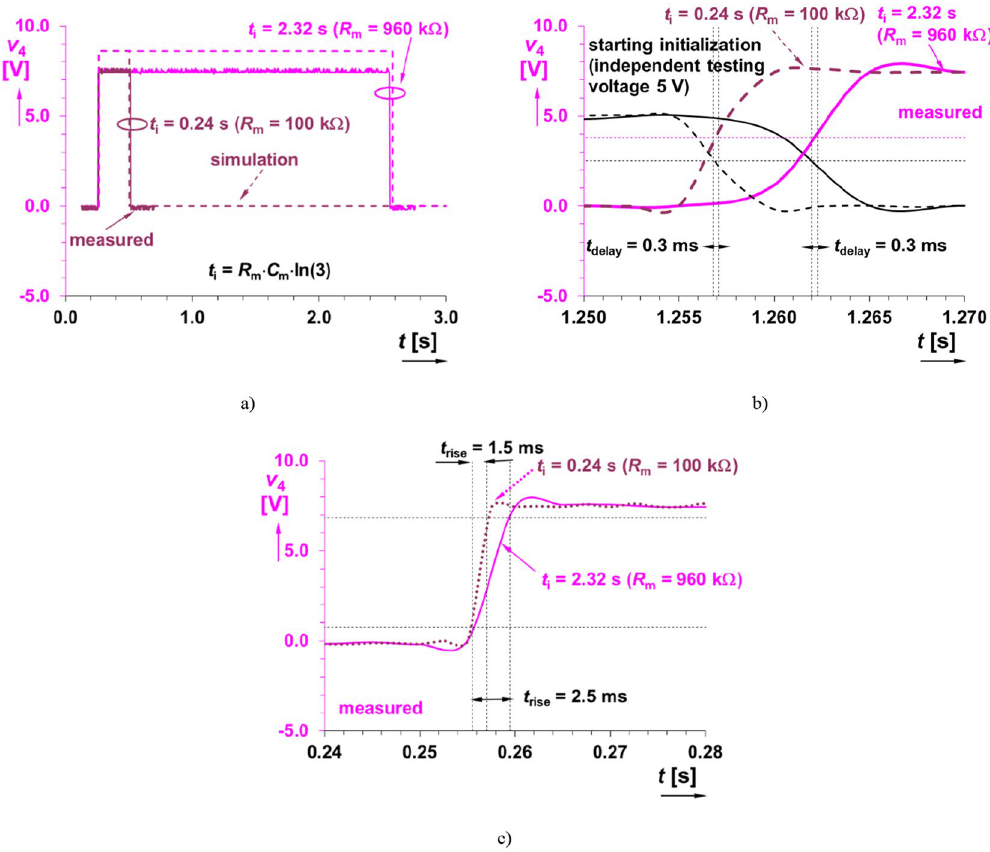
Figure 5. Time domain example of various interval of temporarily stable state of monostable flip-flop: ( a ) full impulse scale, ( b ) detail on initialization for delay and ( c ) detail on initialization for rise time.